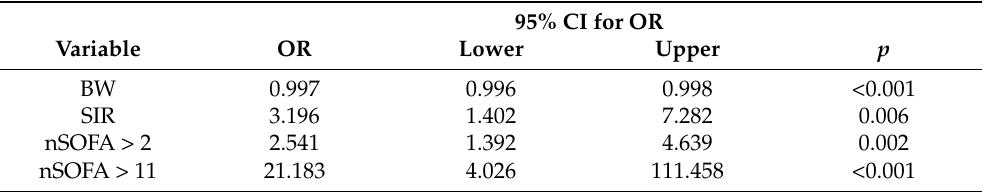
Table 3. Multiple logistic regression (stepwise forward) for adverse hospital outcome (death or severe morbidity) of very preterm infants in study